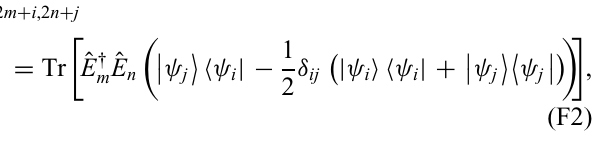
√ 3 code discovered with d = 2